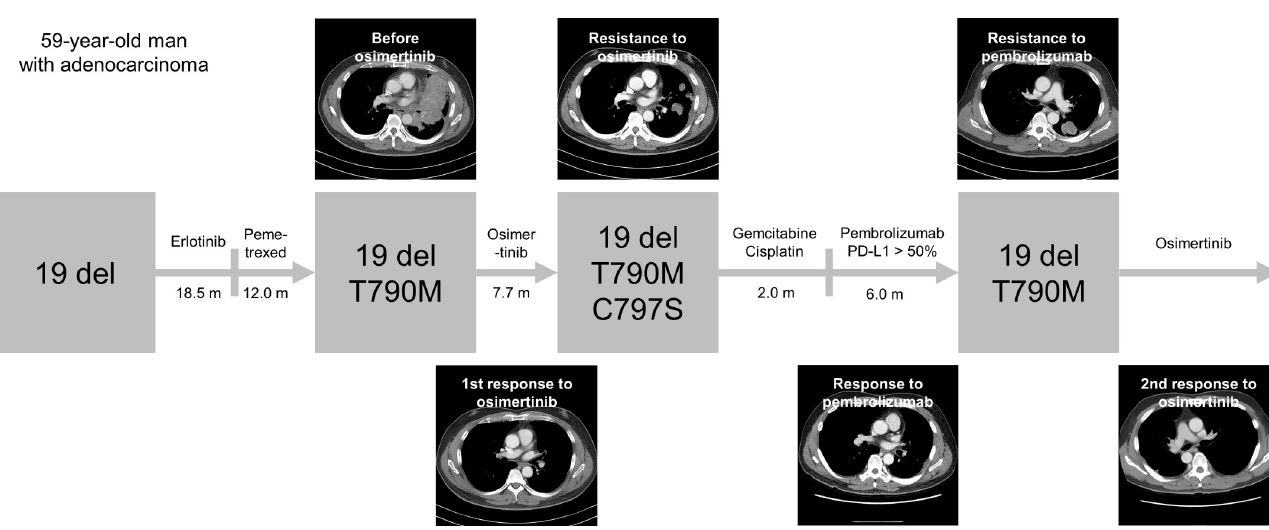
Fig 4. Longitudinal response to treatment in a patient with the C797S